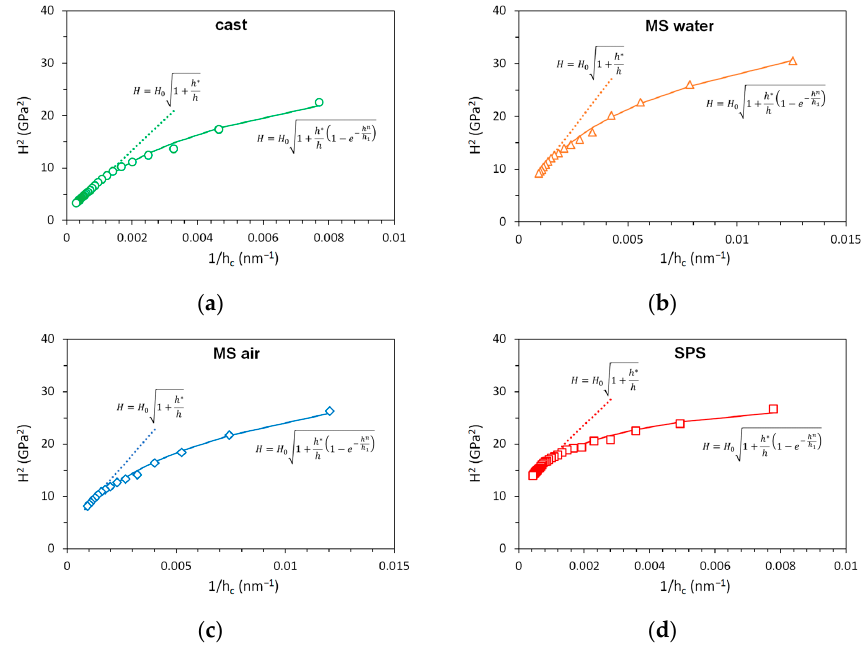
Figure 5. Depth dependence of hardness of CoCrFeMnNi samples: ( a ) cast; ( b ) MS-water; ( c ) MS-air; ( d ) SPS.